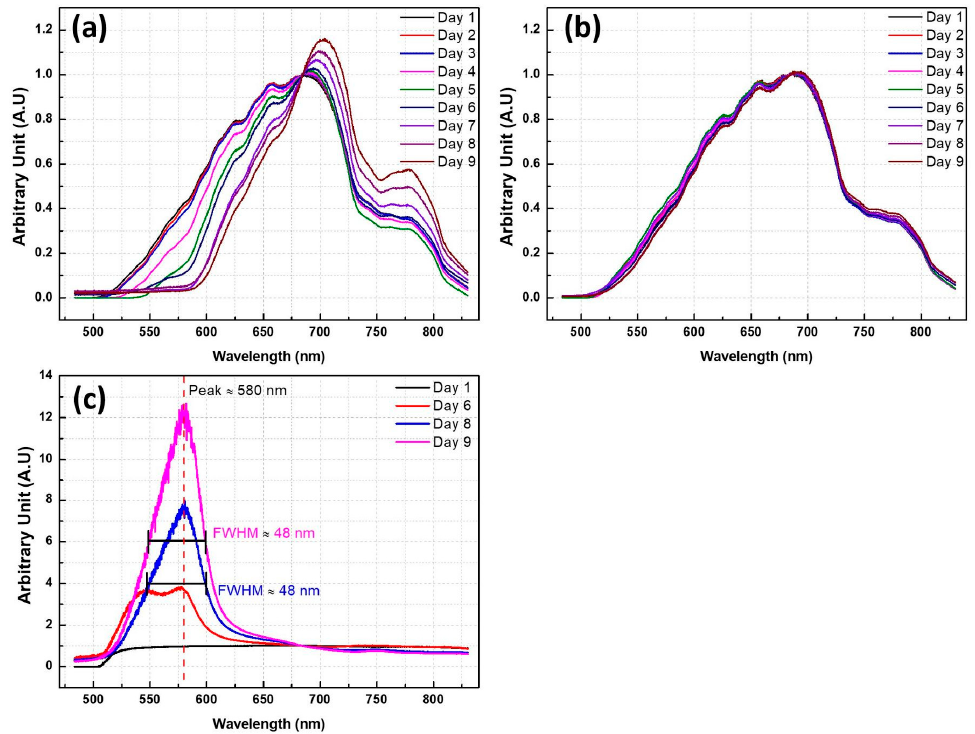
Figure 3. ( a ) Average values of fertilized egg spectral data on Days 1–9; ( b ) average values of unfertilized egg spectral data on Days 1–9; and ( c ) average values of unfertilized eggs divided by average values of fertilized eggs.